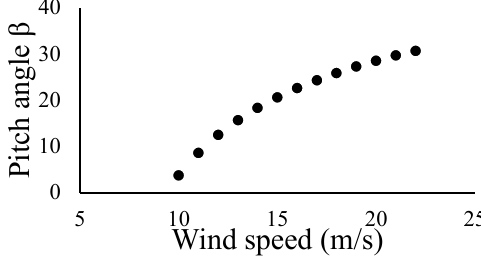
Figure A1. Wind speed-Pitch Angle curve. (2) Variable rotor controller